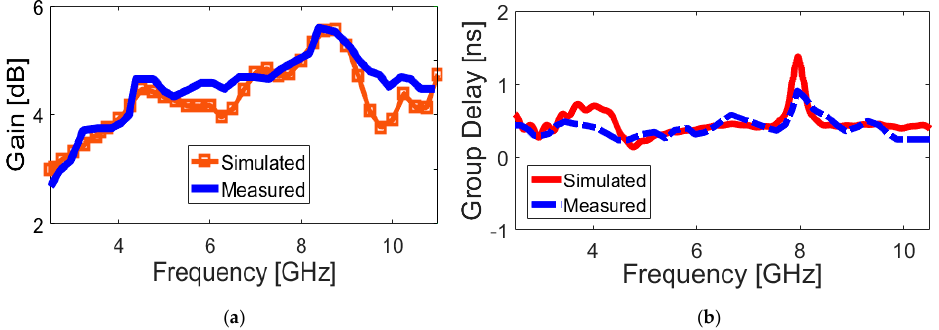
Figure 15. Measured and simulated ( a ) antenna gain and ( b ) group delay over its ultra wide